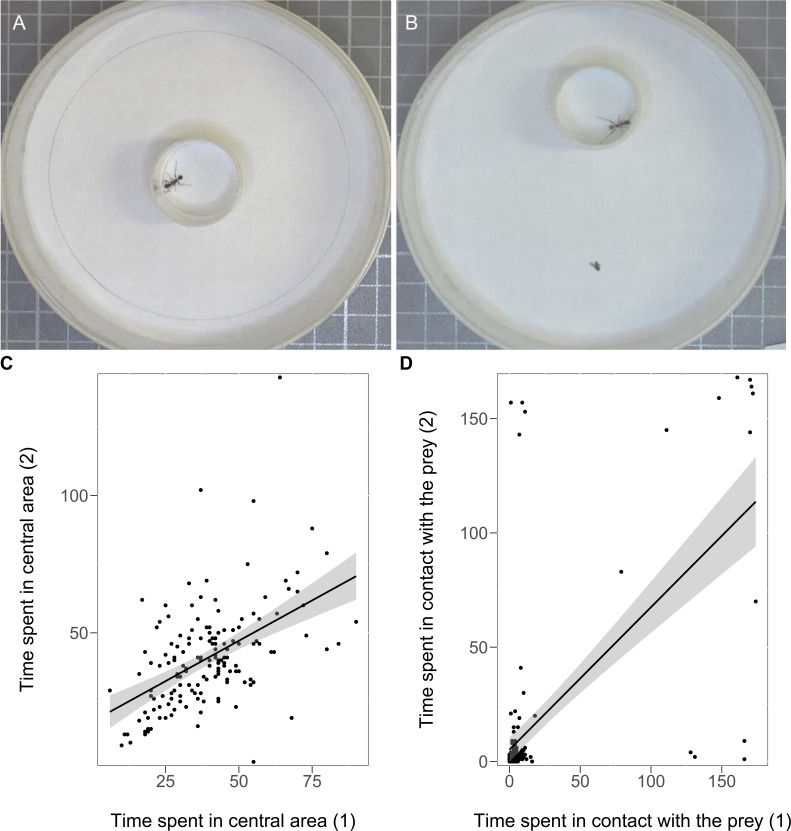
Experimental set-up used for the open-field (A) and the reaction to prey tests (B).The ant is in the acclimatisation tube for 1 min and the test starts when the tube is removed (see Materials and methods). The consistency across the two sessions of the open-field test regarding the time spent in the central area (C) and the consistency across the two sessions of the reaction to prey test (D). The black line with confidence band (grey) is plotted based on the Pearson correlation of the two variables.Figure 3—source data 1.Experiment 3 - correlation between the two sessions (repeats) for the time (sec) spent walking in the central area (open-field test) by individual ants.Repeatability across the two sessions, for each individual ant, concerning the time spent walking in the central area was assessed with intra-class correlation (Lessells and Boag, 1987) by using LMM (Nakagawa and Schielzeth, 2010). The total time spent in the central area were significantly repeatable across the two sessions (N = 154; p<0.0001). Six ants died between the two sessions of the personality tests, therefore the sample size is 154 ants instead of 160 (20 ants in each of the eight sub-colonies).Figure 3—source data 2.Experiment 3 - correlation between the two sessions (repeats) for the time (sec) spent in contact with the prey (reaction to prey test).Repeatability across the two sessions, for each individual ant, concerning the time spent in contact with the prey was assessed with intra-class correlation (Lessells and Boag, 1987) by using LMM (Nakagawa and Schielzeth, 2010). The time spent in contact with the prey was highly repeatable (N = 154; p<0.0001). Six ants died between the two sessions of the personality tests, therefore the sample size is 154 ants instead of 160 (20 ants in each of the eight sub-colonies).